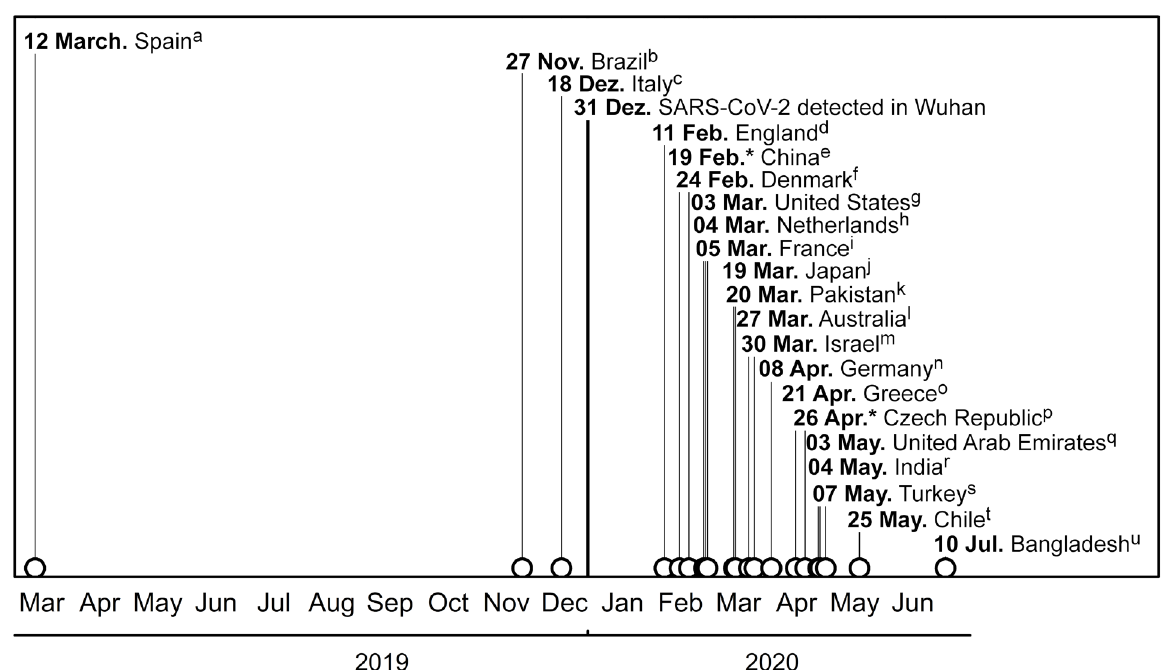
Figure 1. Time course of SARS-CoV-2 detections in wastewater References: a: Chavarria-Miró et al. (2020), b: Fongaro et al. (2020), c: La Rosa et al. (2020a), d: Martin et al. (2020),